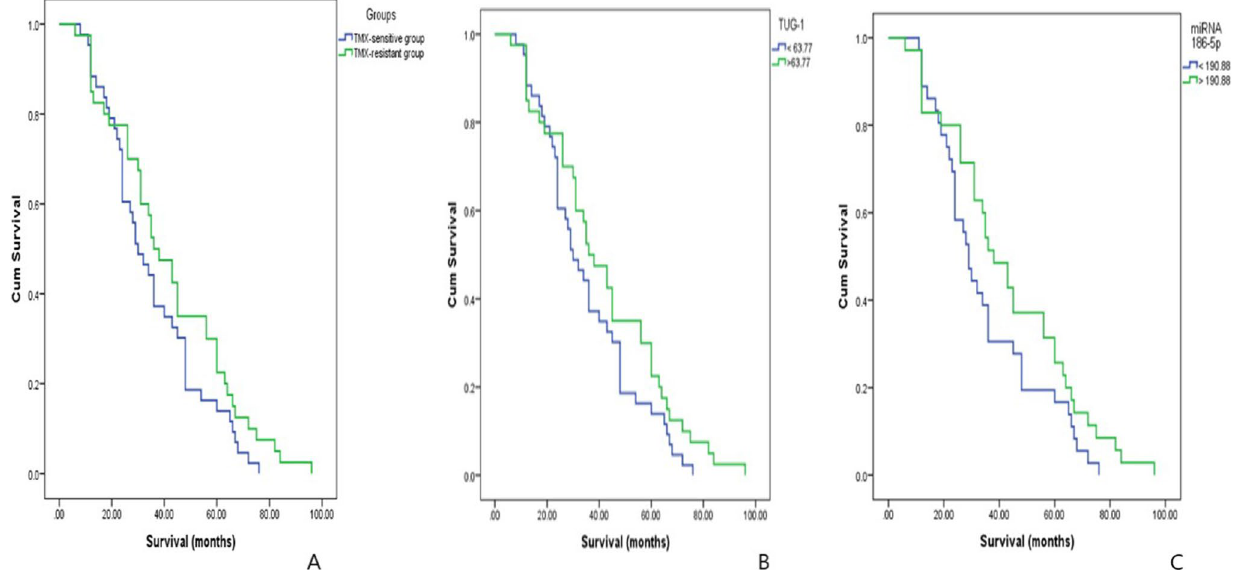
Figure 3. Kaplan–Meier analysis. In this figure, Kaplan–Meier analysis was used to assess the relation between different parameters and survival (months) and also to compare between resistant and sensitive groups using Log Rank test. ( A ) Comparison between TMX‑sensitive and TMX‑resistant groups regarding overall survival (months) shows that there was no statistical significant difference found between TMX‑sensitive group and TMX‑resistant group regarding overall survival with P value = 0.117. ( B ) The relationship between TUG‑1 with survival (months) shows that there was no statistical significant difference found in TUG‑1 regarding overall survival with P value = 0.117. ( C ) The relationship between miR‑186 with survival (months) shows that there was no statistical significant difference found in miR‑186 regarding overall survival with P value =